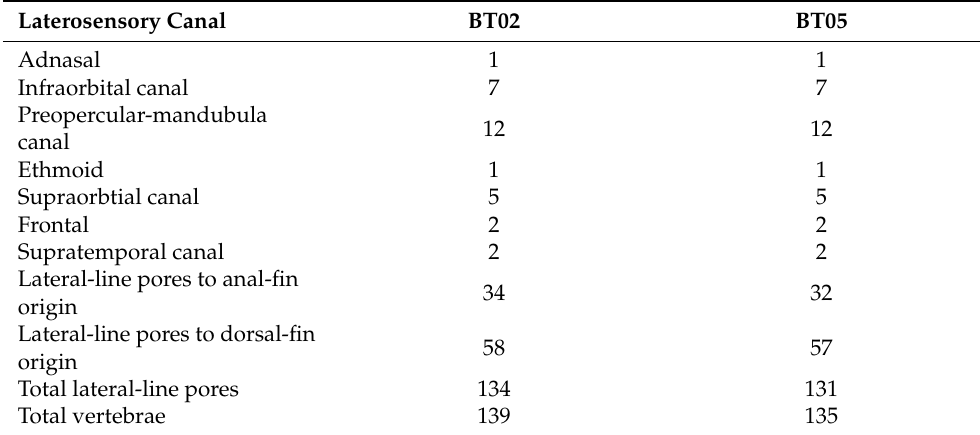
Table 3. Meristic characters of the two eel specimens collected from the East Mariana Basin, western Pacific Ocean. Data based on specimens listed in Table 2.